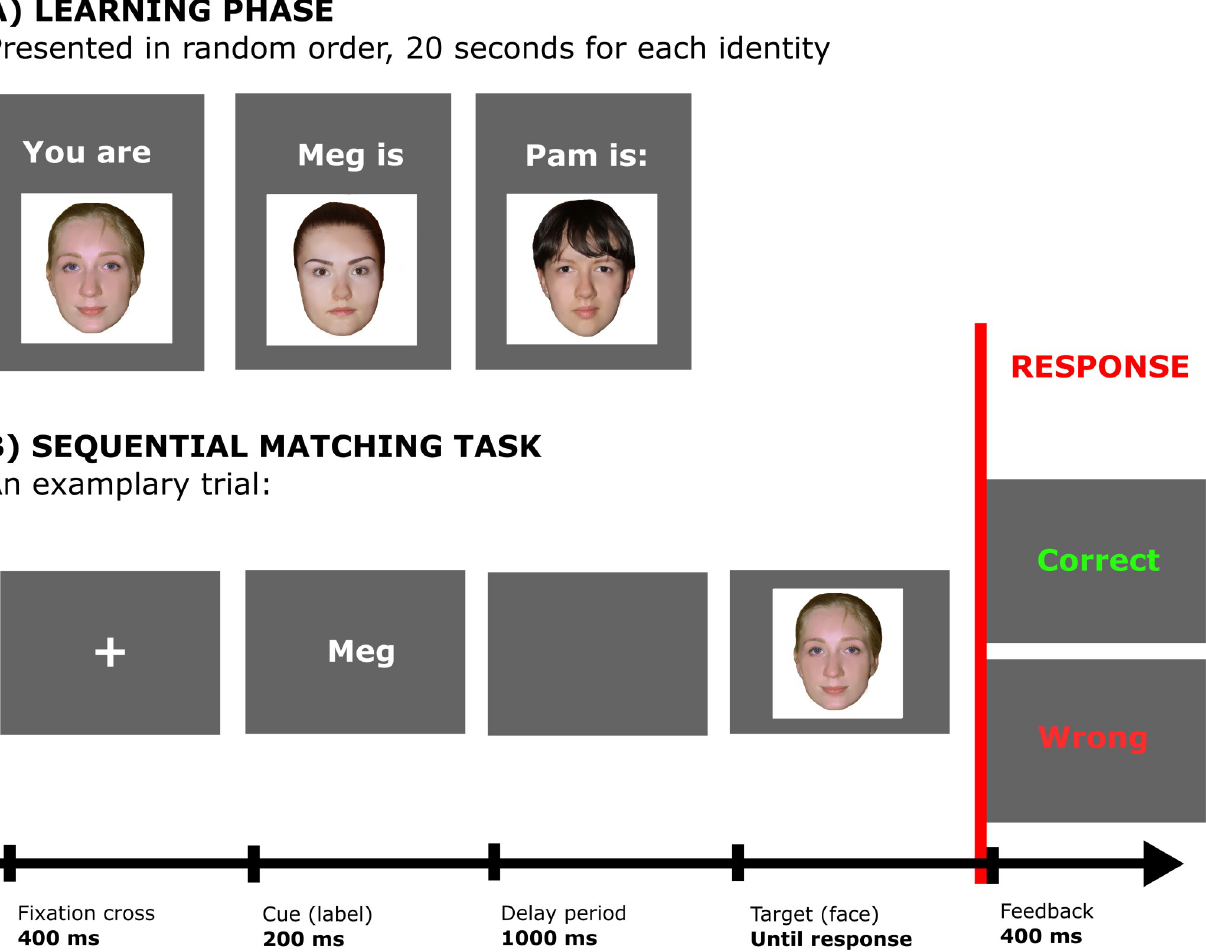
Fig 1. The procedure of Experiment 1. (A) During the learning phase participants were told which face corresponds to which identity, as indicated by a label “You”, and two names. (B) In the matching task participants were first presented with a label and then, after a 1 second delay, with a face. Their task was to judge whether the face matched with the label or not. Feedback was provided immediately after providing the response. (The faces in Fig 1 are for illustrative purposes only and they are not the actual faces used in the experiment; the individuals in the figure gave written consent to publish their